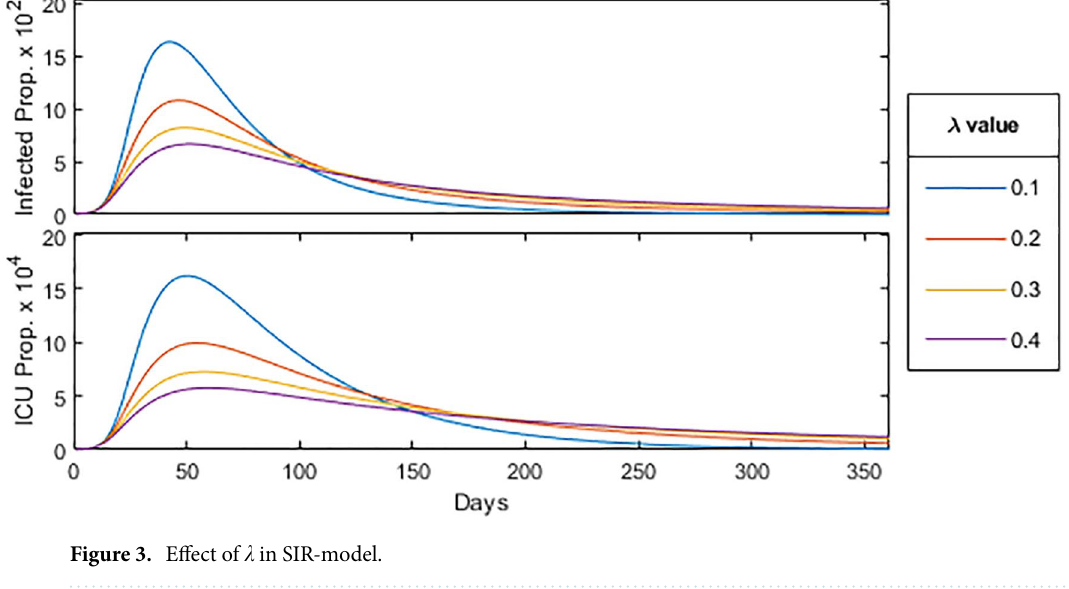
Figure 3. Effect of (cid:31) in SIR-model.